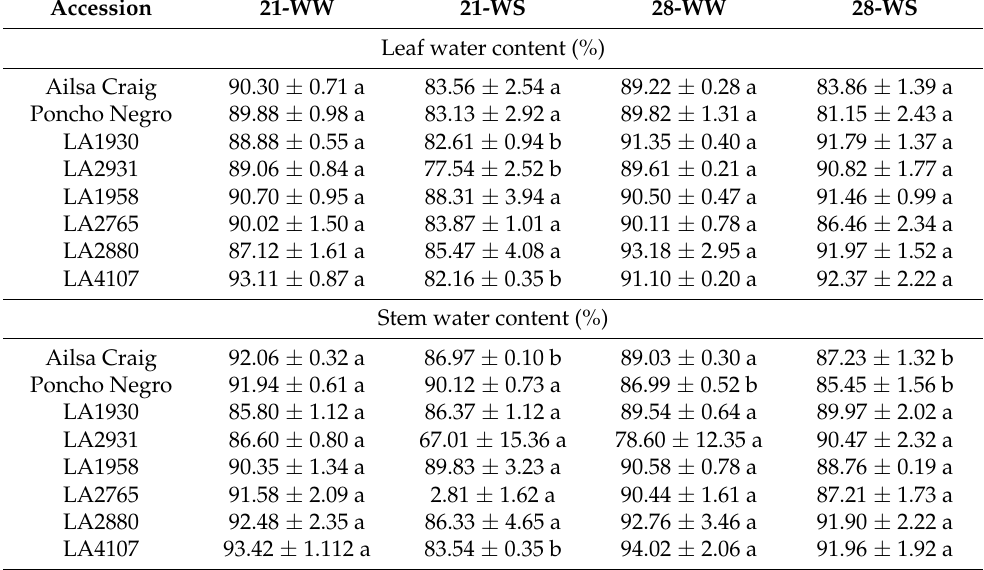
Table 3. Effect of temperature and water stress on water content of S. lycopersicum cultivars and S. chilense populations. For a given accession, treatments followed by different letters are significantly different at p < 0.05. Data ±